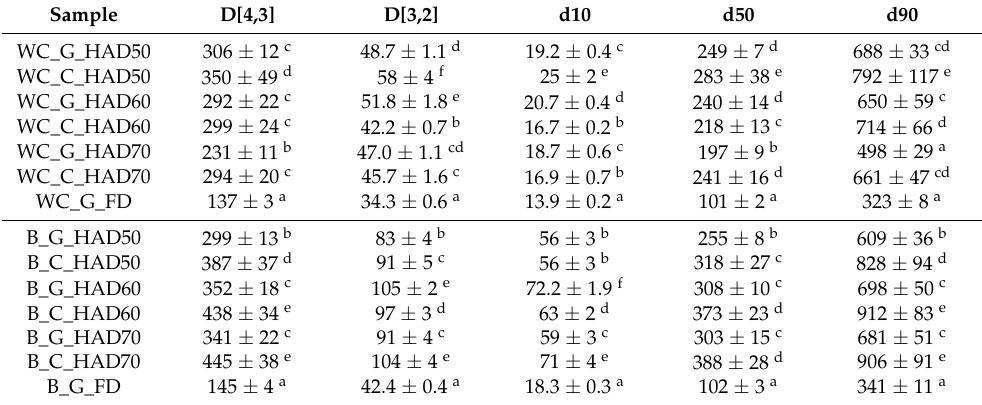
Table 2. Particle size characteristic parameters of white cabbage (WC) and broccoli (B) powders: equivalent volume diameter D[4,3], surface area mean diameter D[3,2], percentiles d 10 , d 50 and d 90 . HAD: hot-air drying at 50, 60 and 70 ◦ C, FD: freeze drying; C: chopped; G: ground. Mean ±